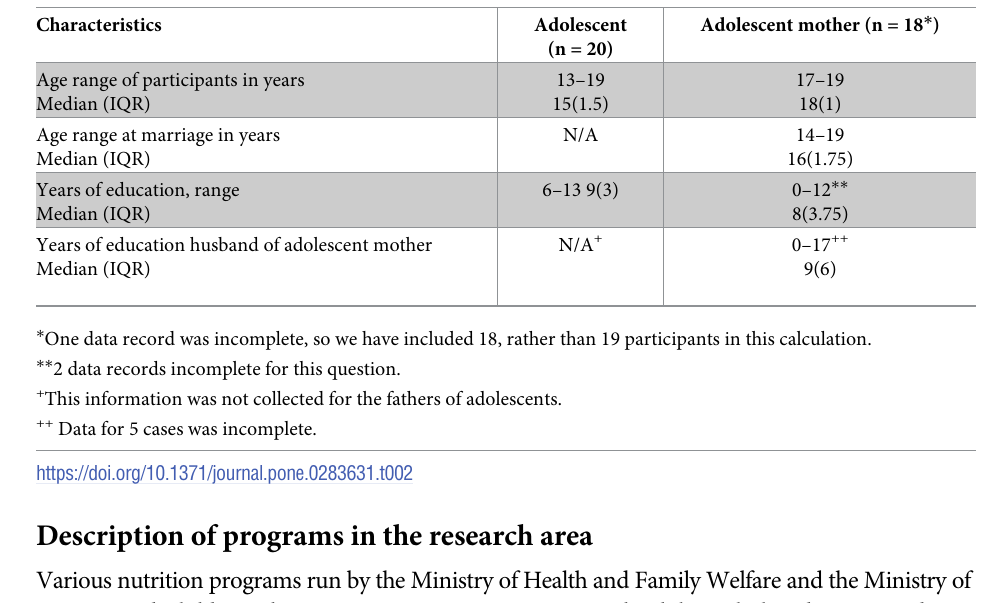
Table 2. Characteristics of adolescent